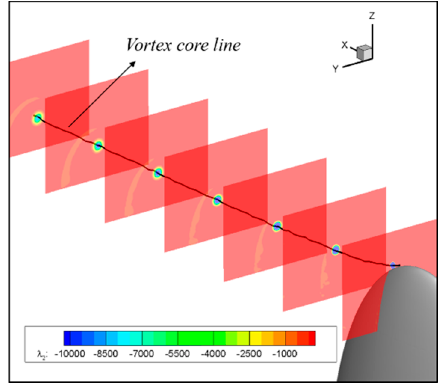
Figure 14. Vortex core trajectory identified using λ 2 criterion.